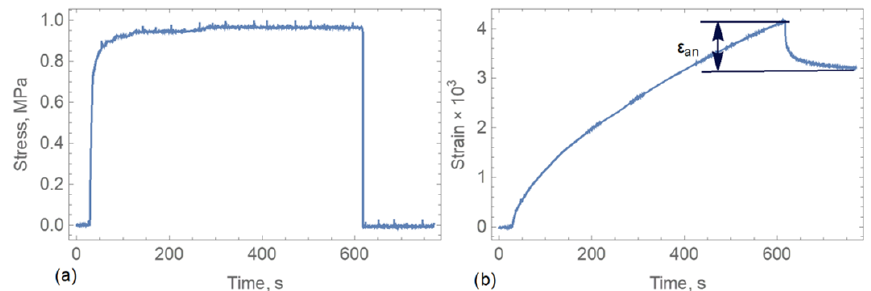
Figure B4. Stress and strain versus time in LU test with an ice core of spray ice (ice temperature is 5 ◦ C).